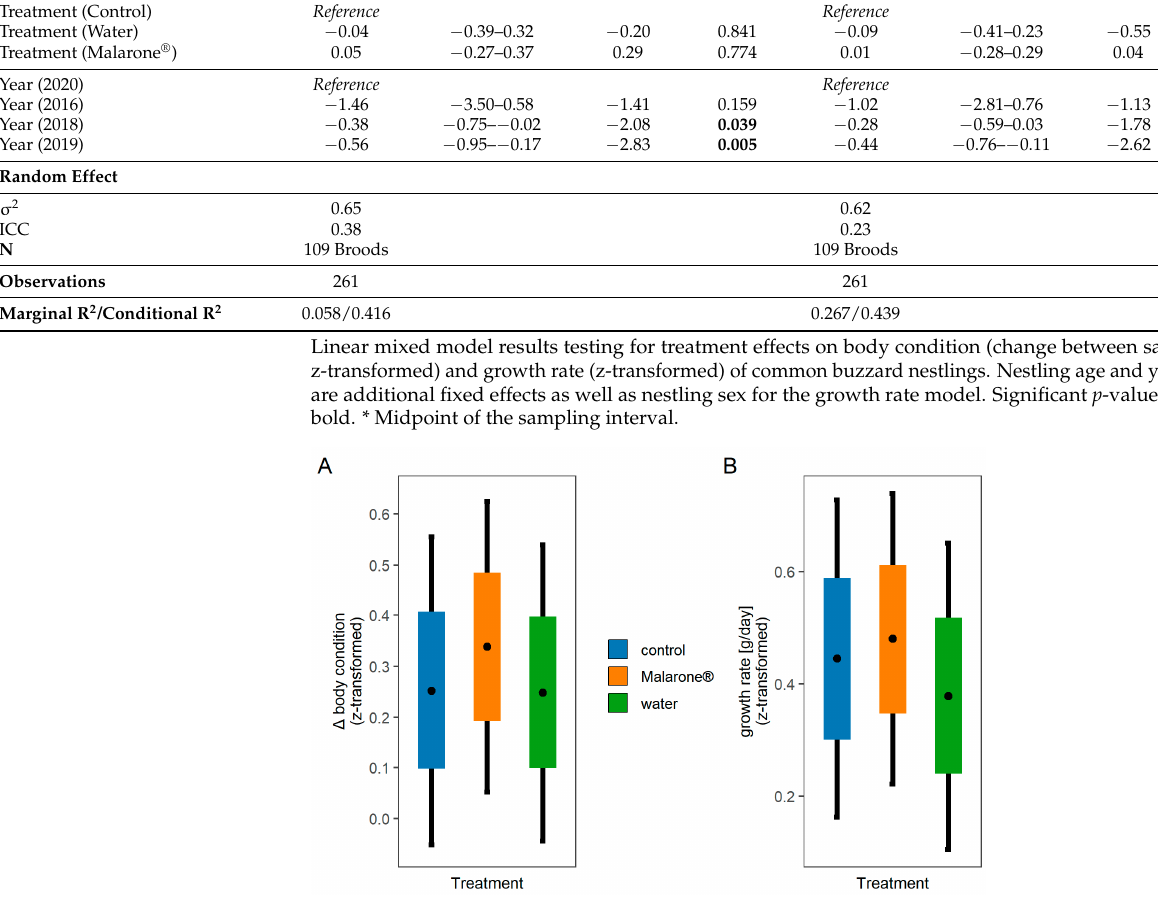
Figure 1. Effects of treatment and control on body condition and growth rate. Visualisation of the predicted values of ( A ) body condition and ( B ) growth rate from linear mixed models testing the effect of treatment (control, Malarone ® , and water) on these two fitness proxies. Black dots represent mean estimates for each of the treatment groups. Main boxplots represent standard deviations, and error bars indicate 95% confidence intervals. See Table 1 for statistical comparison of treatment groups.